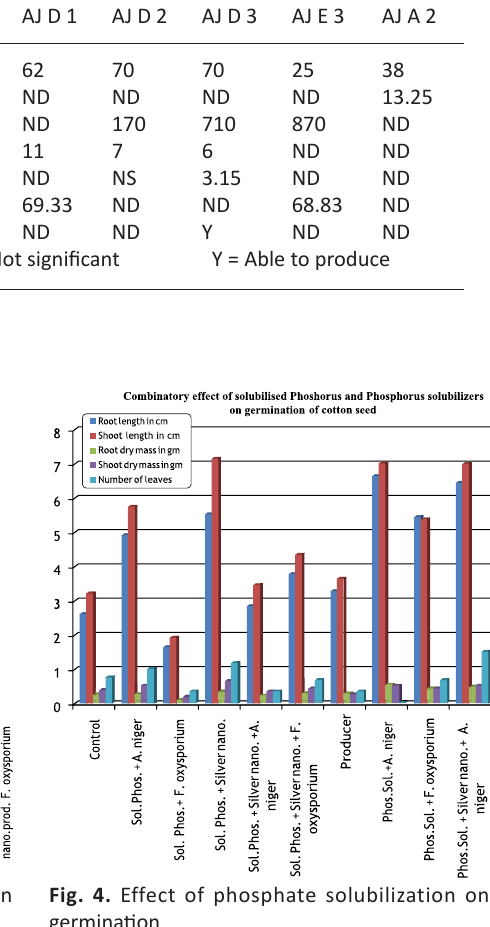
Table 4. Main characteristics of selected isolates Metabolite/